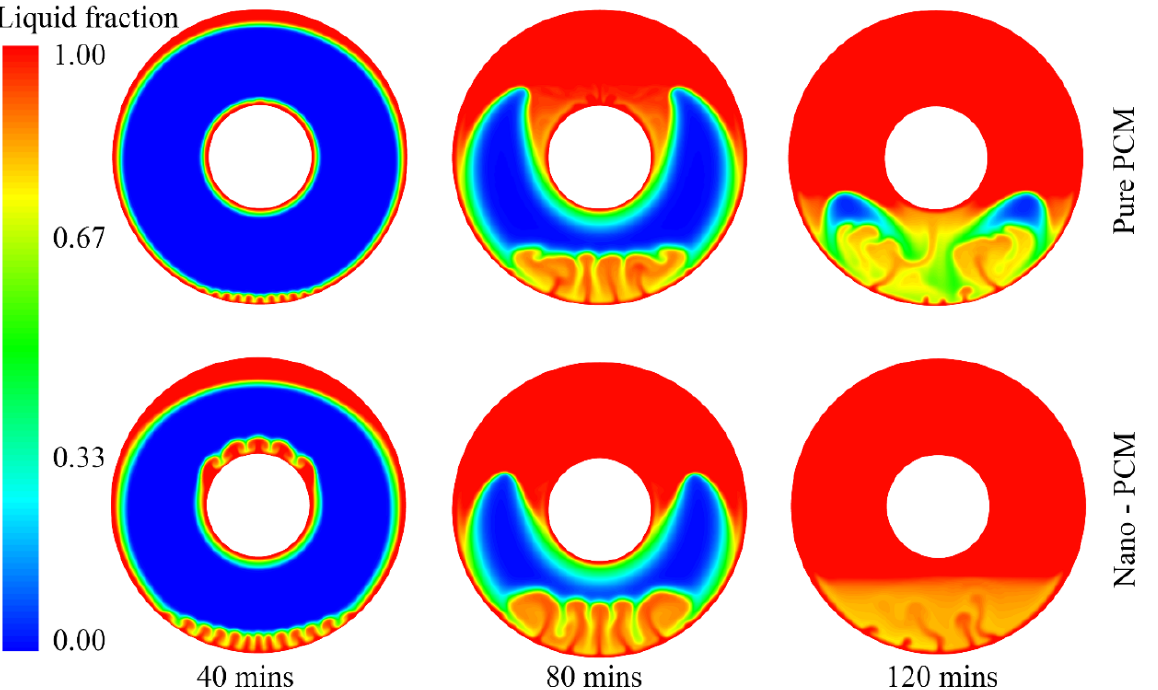
Figure 10. Liquid fraction of PCM during the melting processes with and without nanoparticles. The addition of Al 2 O 3 nanoparticles significantly enhances the melting performance of PCM during the initial stage. For example, the thickness of the melted PCM around the hot outer wall with Al 2 O 3 nanoparticles is approximately twice that of the pure PCM at t = 40 min. In addition, the Al 2 O 3 nanoparticles dramatically improve natural convection at the bottom of the outer wall compared to the pure PCM case. For the inner wall, the